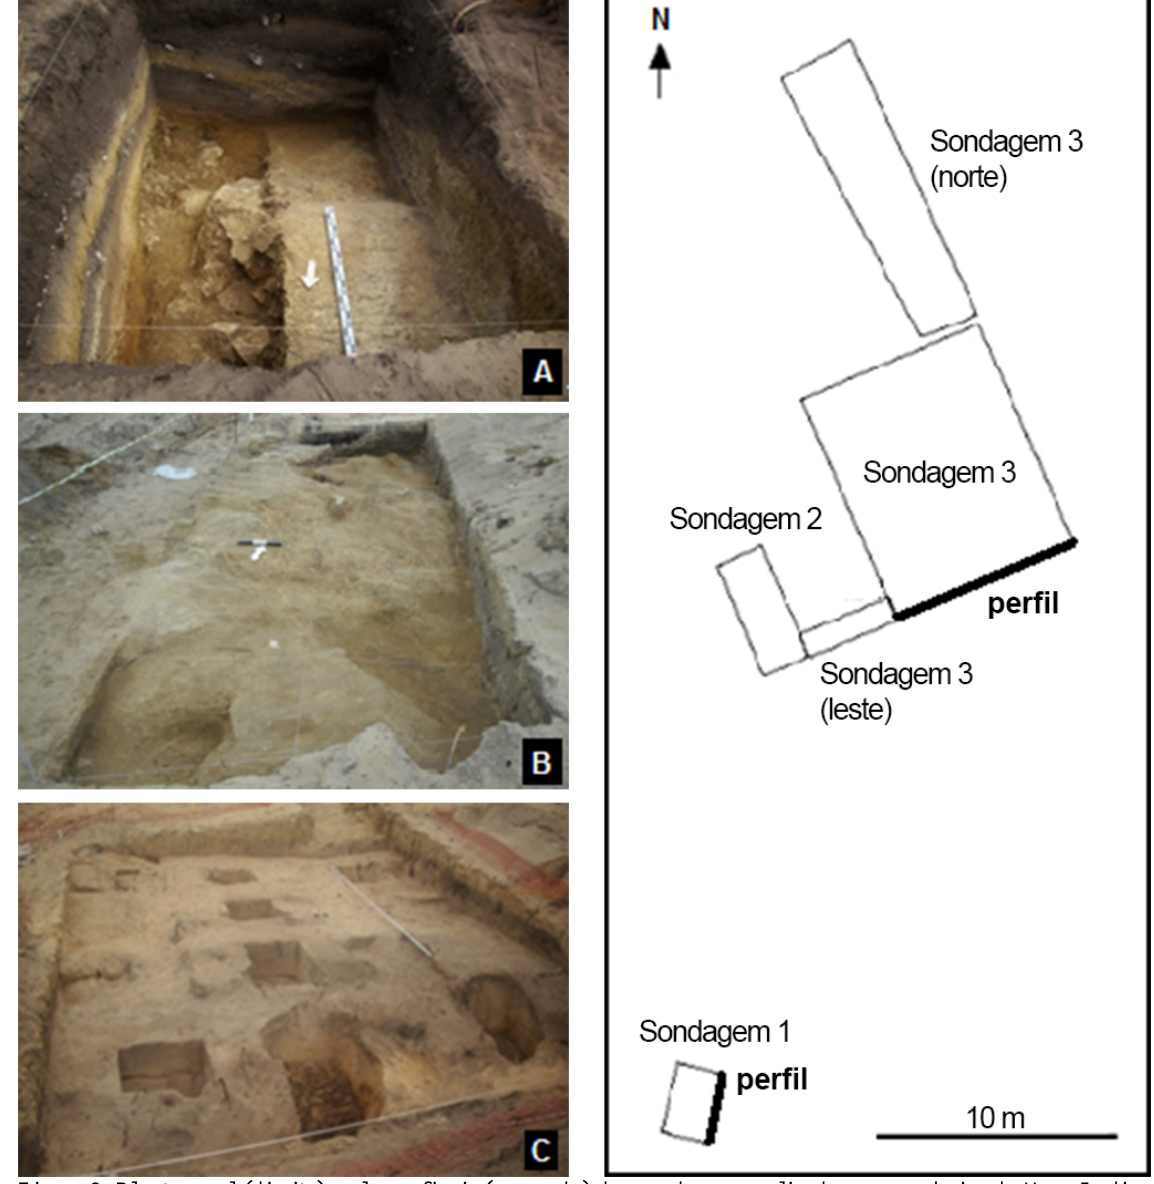
Figura 3. Planta geral (direita) e planos finais (esquerda) das sondagens realizadas no concheiro do Meu Jardim, com indicação dos perfis estratigráficos das Sondagens 1 e 3 (ver Figure 4). A: Sondagem 1; B: Sondagem 2; C: Sondagem 3. Figure 3. General plan (right) and final plans (left) of the tests excavated at the shell-midden of Meu Jardim, with location of the stratigraphic profiles of Tests 1 and 3 (see Figure 4). A: Test 1; B: Test 2; C: Test